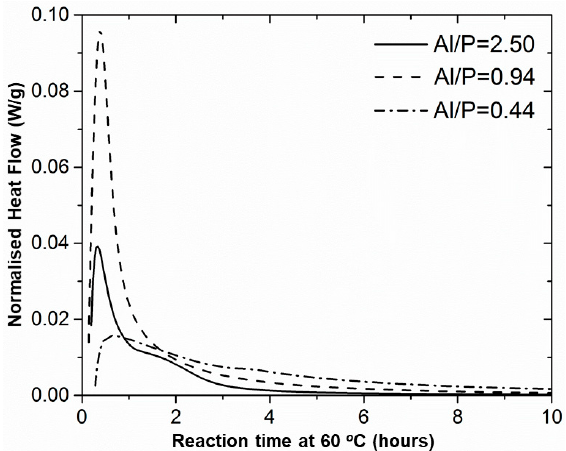
Figure 1. Evolution of reaction enthalpy as a function of Al/P molar ratio. Isothermally, 60 °C, first 10 hours of experiment.